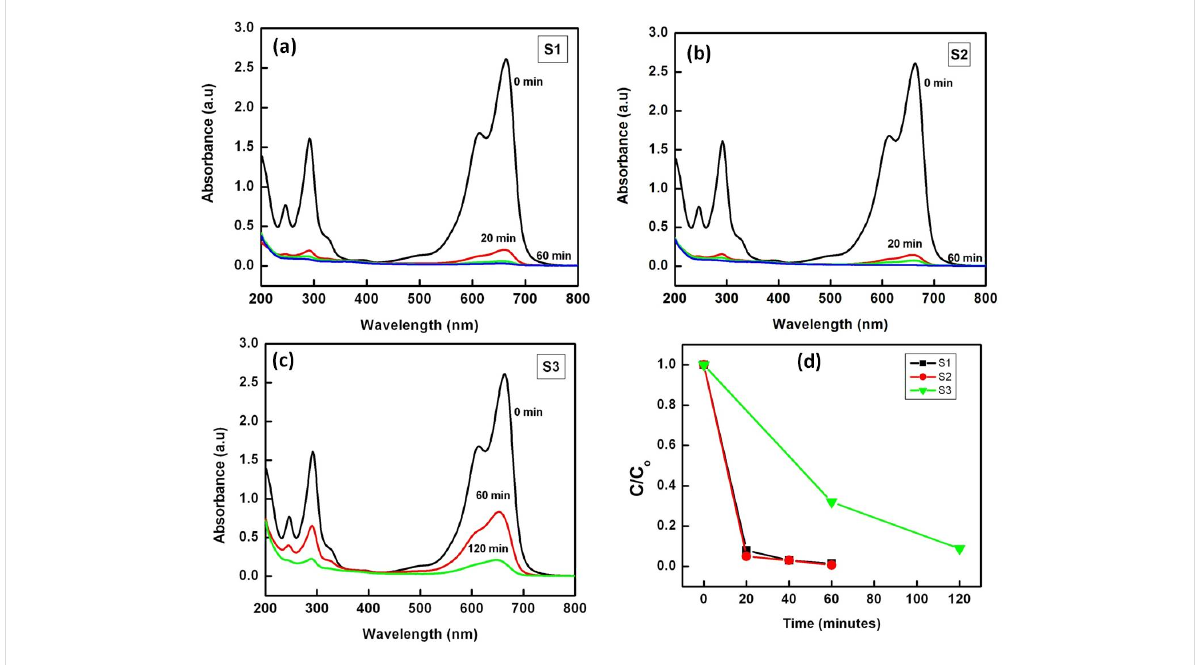
Figure 4: UV–vis absorption spectra showing temporal evolution of photocatalytic degradation of MB upon irradiation with sun light using samples (a) S1, (b) S2 and (c) S3 as photocatalysts. (d) variation of MB concentration with exposure time for different photocatalysts.